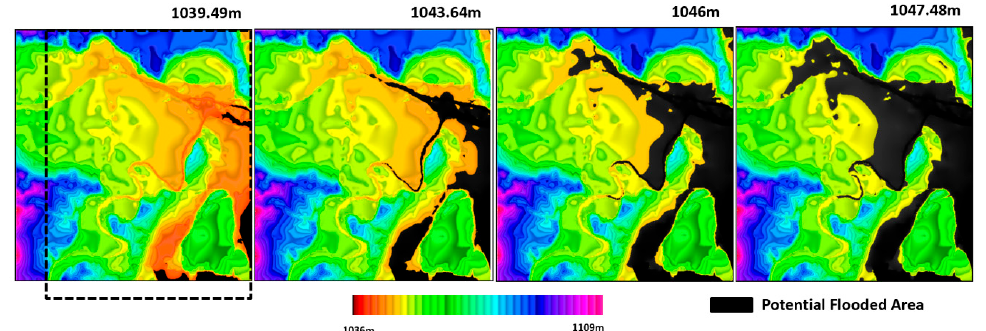
Figure 11. Maps of flooded areas estimated using the digital elevation model (DEM) data only over the center of Calgary (Note: the frame with a dashed line indicates the coverage of Figure 7).